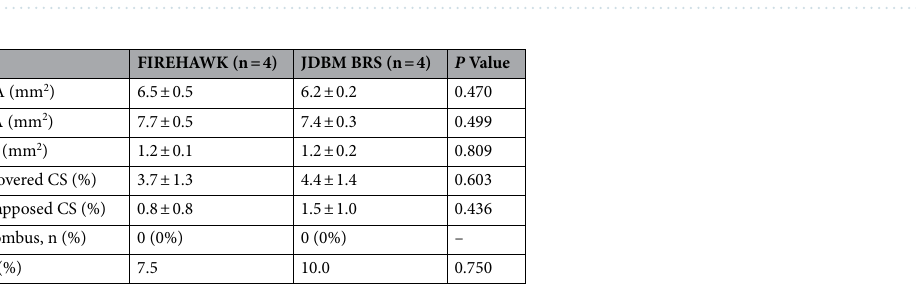
Table 2. OCT findings by cross section level. Values are expressed as mean ± SD. CS, cross section; MLA, mean lumen area; MSA, mean stent area; NIA, neointimal area; NV,